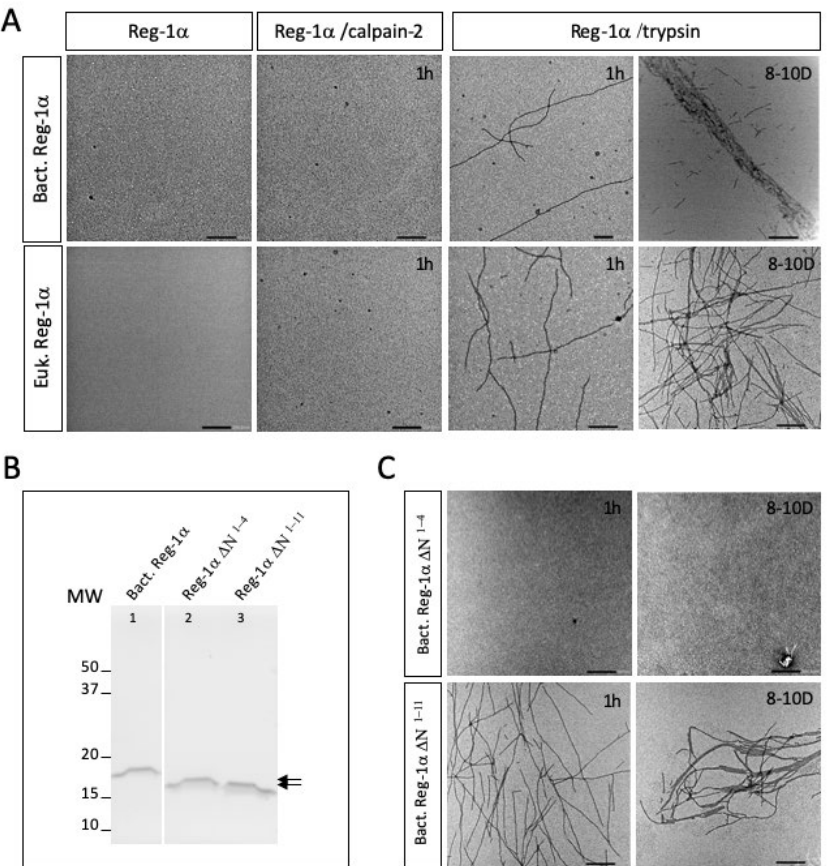
Figure 6. Reg-1 α fibrils are only formed post cleavage of the undecapeptide. ( A ) The two recombinant forms (Bact. or Euk. Reg-1 α ) of the protein were analyzed after calpain-2 or trypsin cleavage at 1h and 8–10 days (8–10D) using electron microscopy. ( B ) Gel electrophoresis of the COOH-terminal domains of Reg-1 α (Reg-1 α ∆ N molecules) after purification using Ni-NTA-agarose beads (see Section 4). Lane 1, intact Reg-1 α from bacteria source; lanes 2–3, supernatant obtained post Ni-NTA resin incubation after calpain-2 (Reg-1 α ∆ N1-4) or trypsin (Reg-1 α ∆ N1-11) cleavage. Note the difference in the molecular weight of the two purified fragments (double arrow). ( C ) Electron micrographs of the purified Reg-1 α ∆ N molecules, post calpain-2 (top panel) and trypsin (bottom panel) cleavage after 1 h and 8–10D. Scale bars: 200